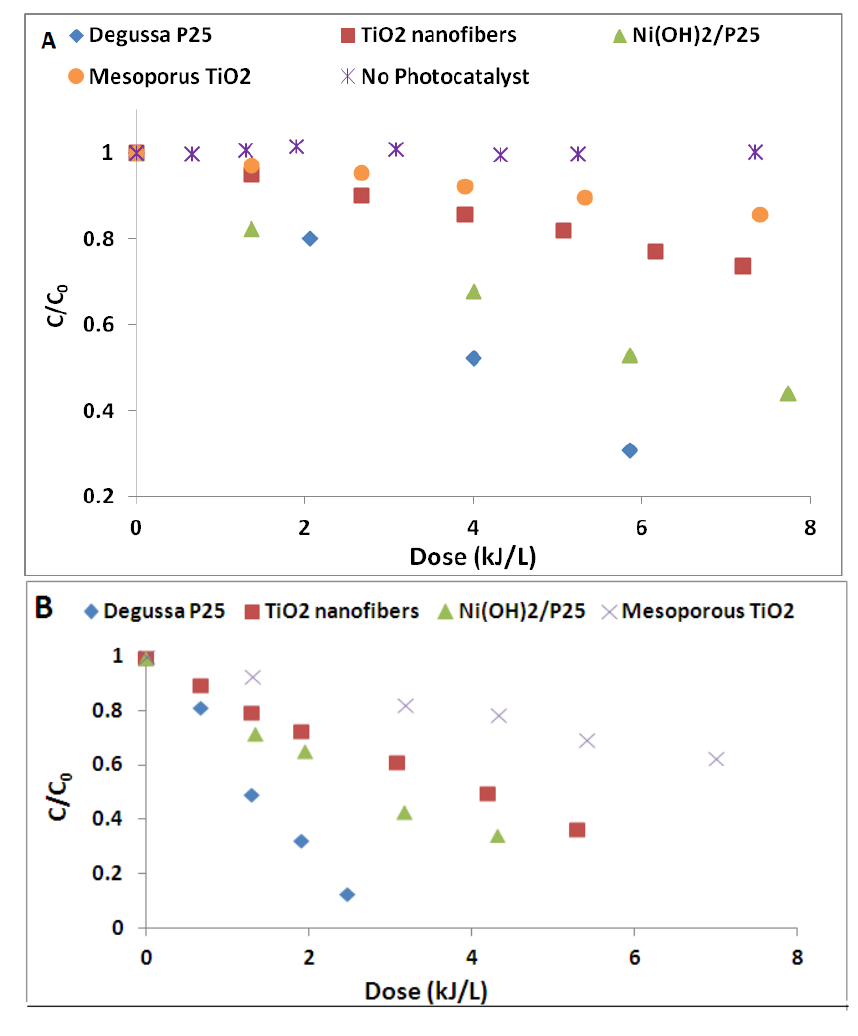
Figure 4. Degradation of 4-CP (33 ppm) irradiated in 365 nm LED reactor using Degussa P25, TiO nanofibers, Ni(OH) /TiO and mesoporous TiO without ( A ) and with O bubbling 2 2 2 2 2 (B) . Absorbance at 246 nm was monitored. Irradiation times are converted to required energy per volume in (kJ/L) for the corresponding removal of 4-CP shown on the Y